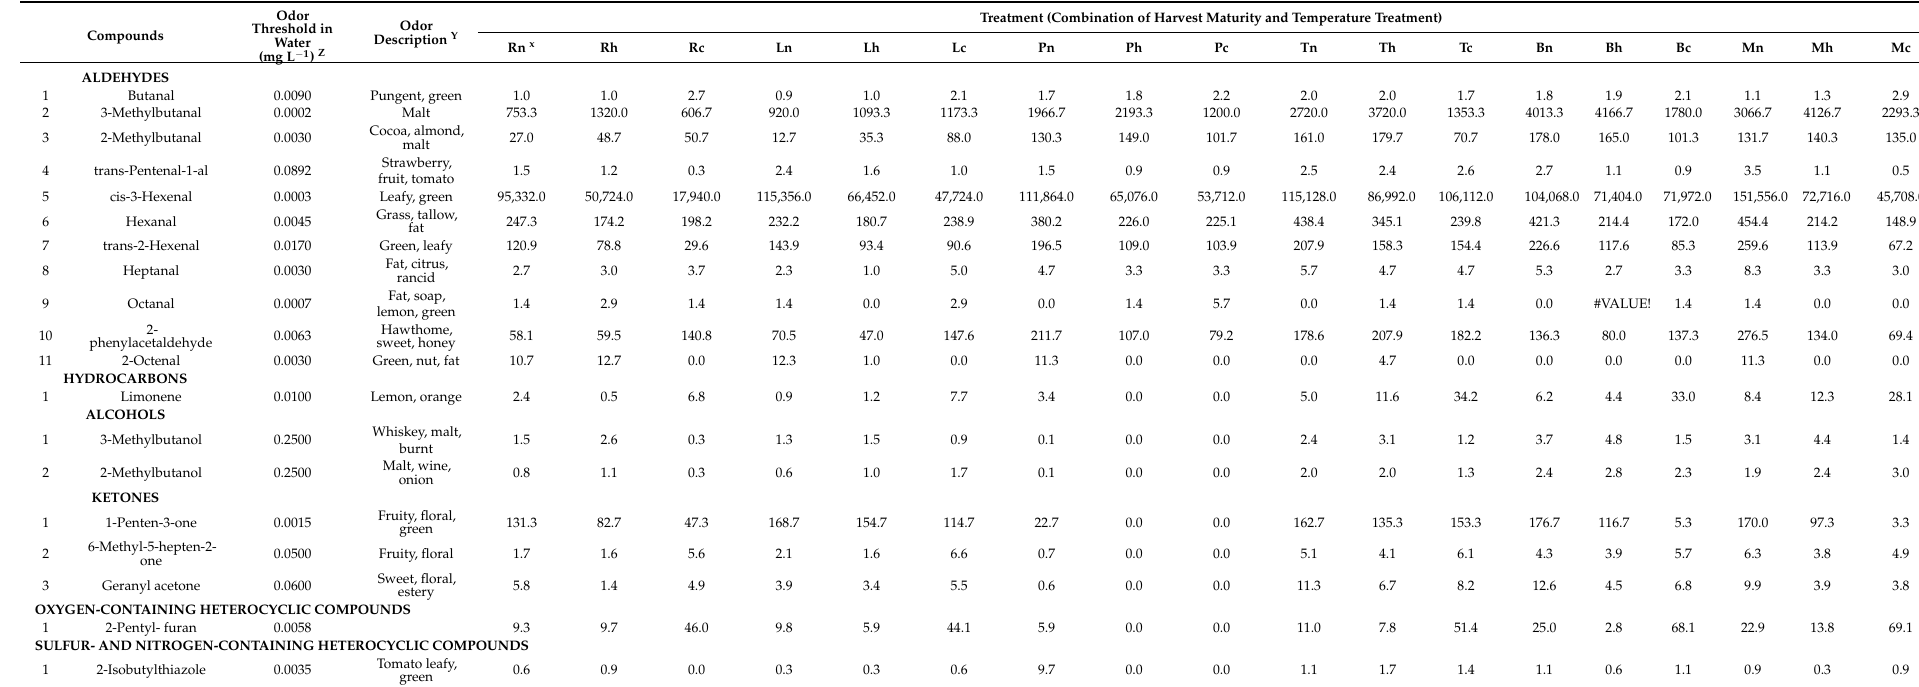
Table 2. Odor activity values (OAVs) of active volatile compounds determined in the different treated tomatoes harvested at six maturity stages and treated by refrigeration (chilling, c), blanching (heating, h), or non-treated (control,